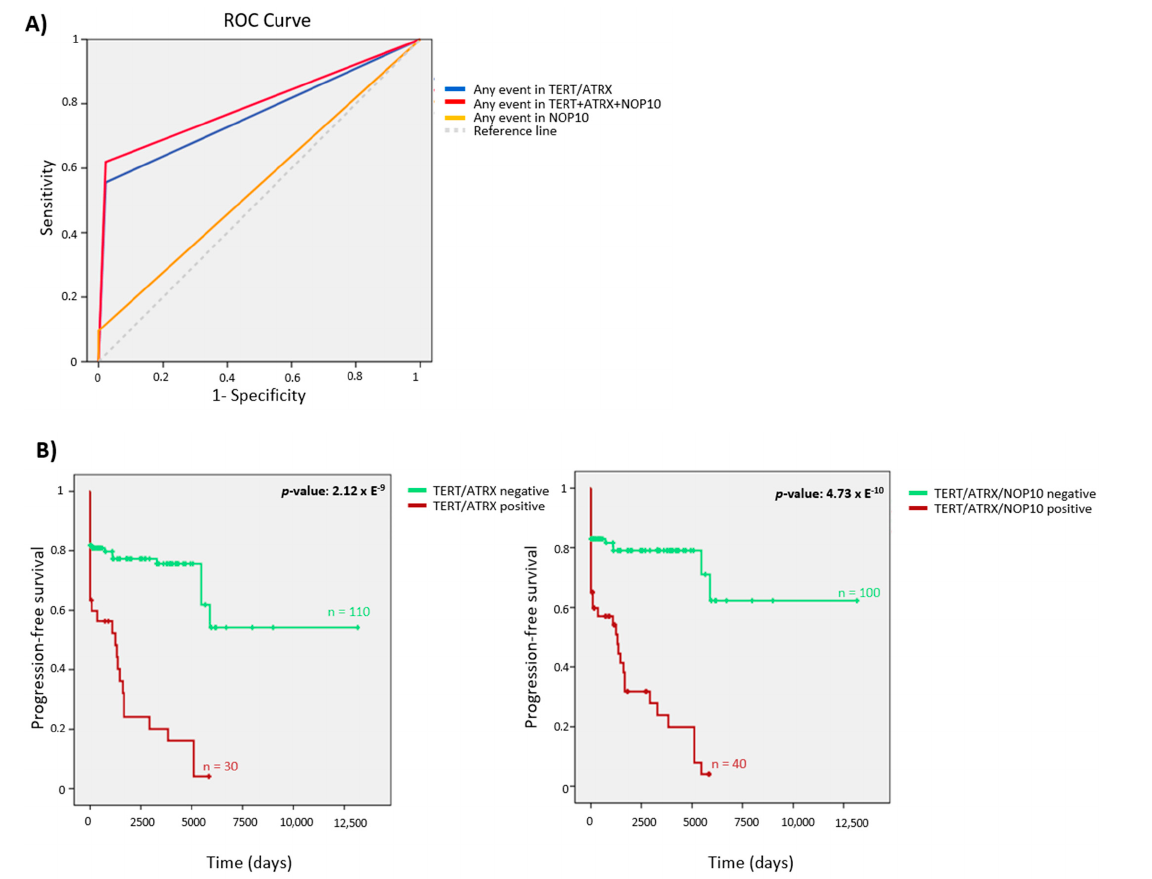
Figure 4. ( A ) Receiver operating characteristic curve (ROC) analysis showing the accuracy of telomerome events to distinguish between metastatic and non-metastatic samples. This data corresponds to all metastatic ( n = 54) and non- metastatic cases with ≥ 8 years of follow-up ( n = 45). Metastases ( n = 9), clinically aggressive samples ( n = 5) and non-metastatic cases with <8 years’ follow-up ( n = 52) were excluded. Genes were introduced as a dichotomous variable based on outlier expressors. TERT events: overexpression, promoter mutation, promoter hypermethylation or gains; ATRX events: low expression outliers and mutations; NOP10 events: overexpression outliers. Any event in TERT + ATRX : p -value: 2.46 × E − 6 , AUC: 0.767; 95%CI: 0.678–0.856; any event in TERT + ATRX + NOP10 : p -value: 1.35 × E − 7 , AUC: 0.798; 95%CI: 0.714–0.882; any event in NOP10 : p -value: 0.439, AUC: 0.548; 95%CI: 0.439–0.656. ( B ) Kaplan–Meier plots of time to progression of patients, according to the events in TERT / ATRX (left) and to the events in the three telomerome significant genes ( TERT / ATRX / NOP10 ) (right). n = number of samples. Log-rank test p -value is shown. Non-metastatic patients with unknown follow-up and those with clinically aggressive tumors were excluded from the